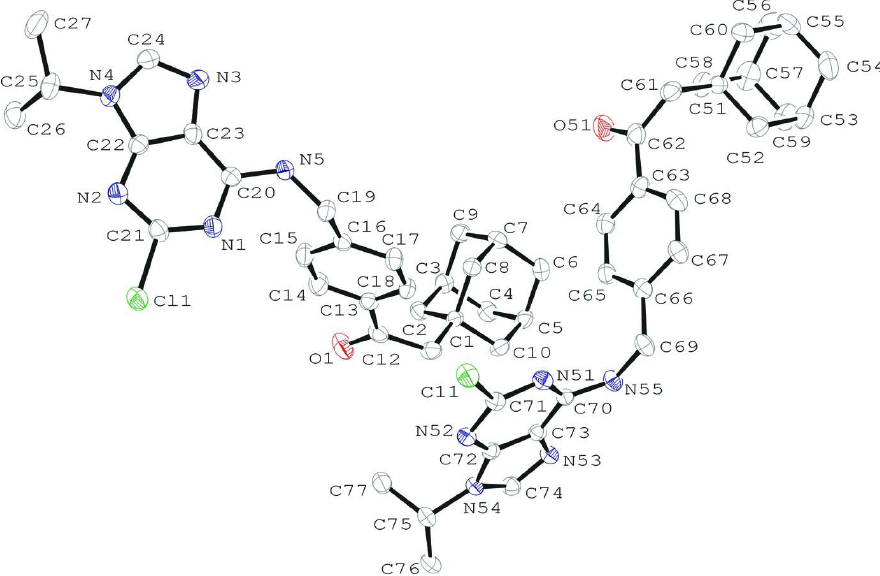
ORTEP of the asymmetric unit with atoms represented as 50% probability ellipsoids. H-atoms have been omitted to enhance clarity.